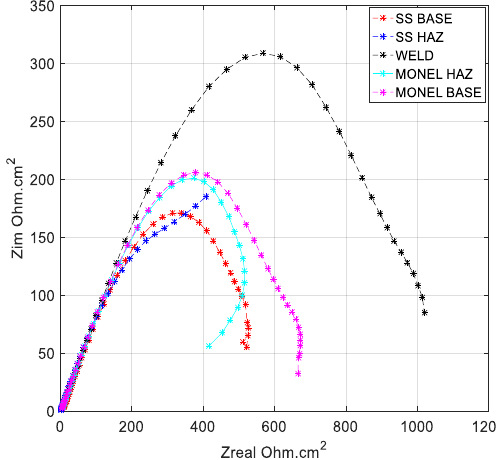
Figure 13. Nyquist plot for HT specimen.